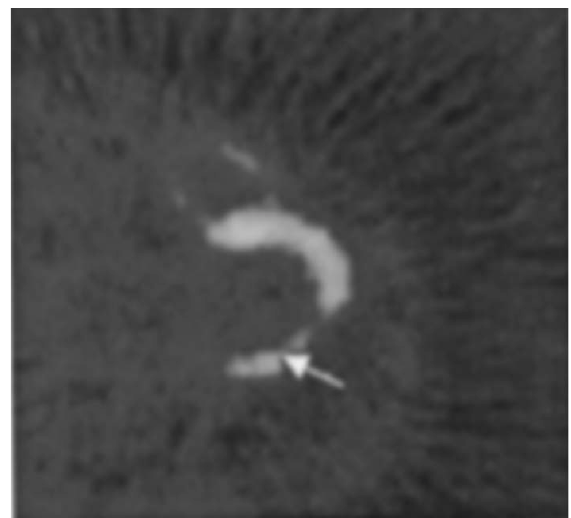
Fig. 1B –Presença de células musculares viáveis na região previa- mente infartada, após quatro meses do transplante de célu- las mioblásticas esqueléticas